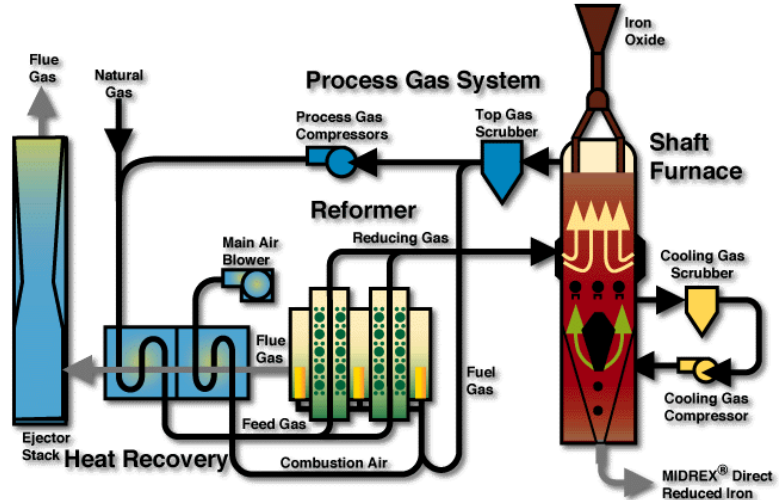
Figure 8. MIDREX direct reduction process [17].